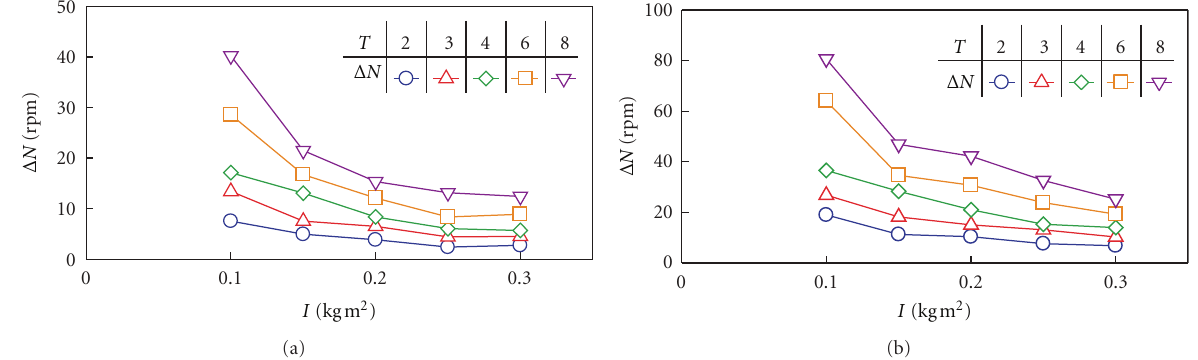
Figure 7: Rotational speed width, Δ N , for wind amplitude (a) Δ V = 1 and (b) Δ V = 2m/s.